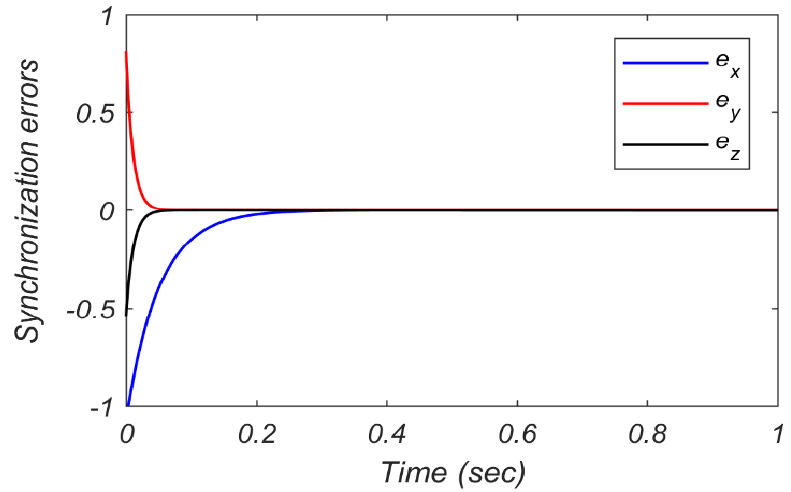
Figure 6. Synchronization error evolution e x , e y , and e z .